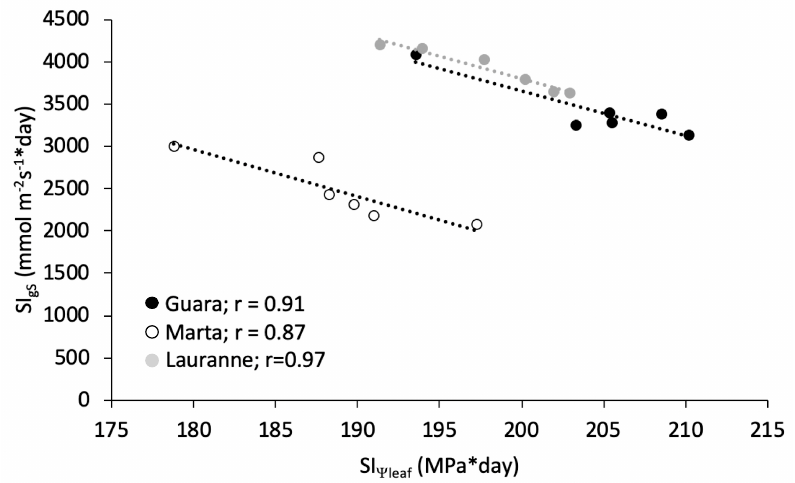
Figure 4. Linear relationships between the stress integral of leaf water potential ( SI leaf ) and stomatal conductance ( SI gs ) for cvs. Guara, Marta, and Lauranne. Each point is defined by the average values for each irrigation treatment, season, and cultivar.